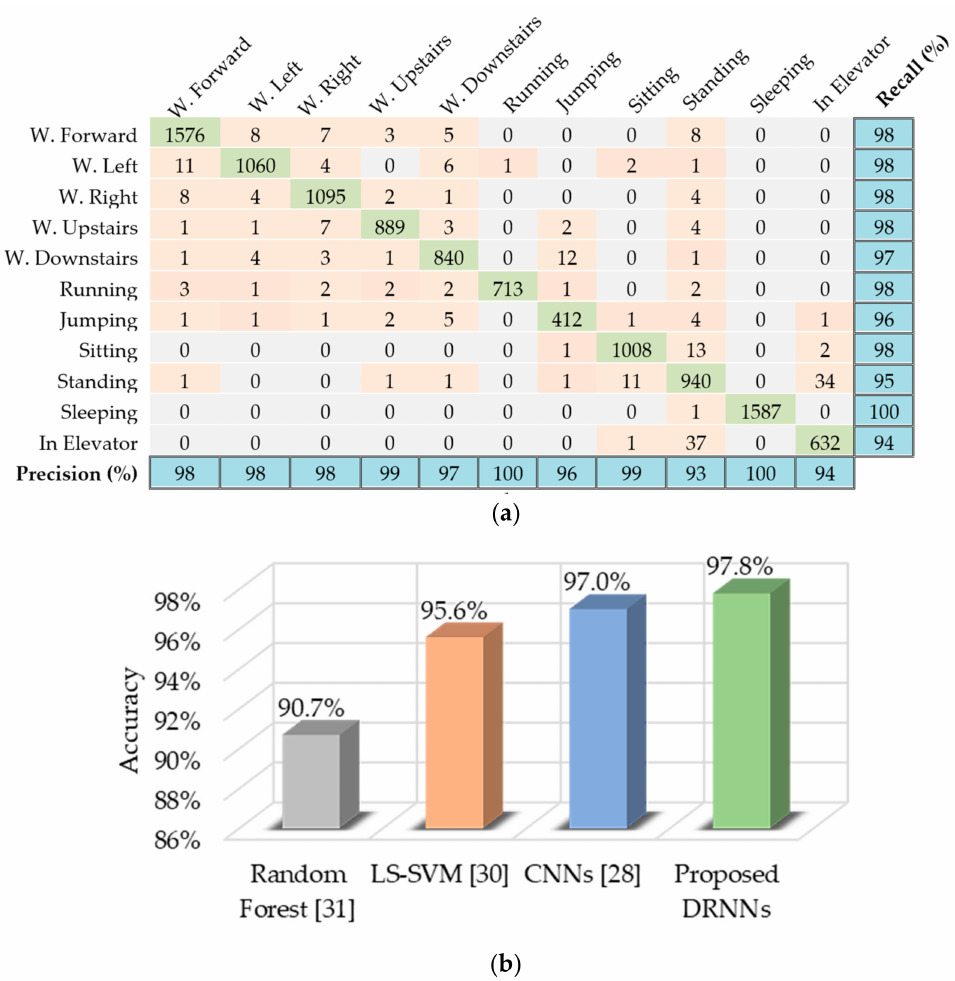
Figure 9. Performance results of the proposed unidirectional DRNN model for USC-HAD dataset: ( a ) Confusion matrix for the test set displaying activity recognition results with per-class precision and recall; ( b ) Comparative accuracy of proposed model against other